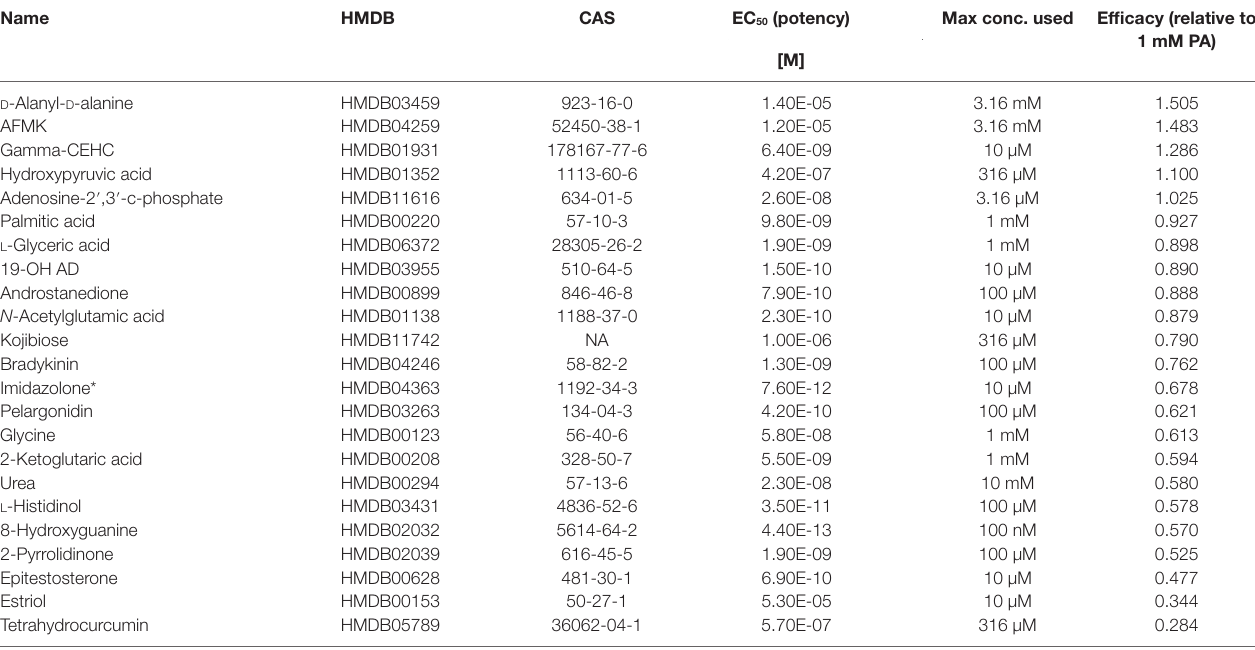
TaBle 1 | Potency and efficacy of 24 newly discovered OR51E2 agonists with their associated HMDB and CAS identifiers.